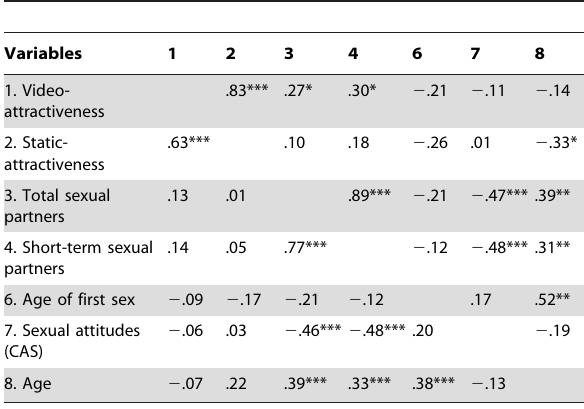
Table 2. Correlations between attractiveness, mating success variables, sexual attitudes and age.